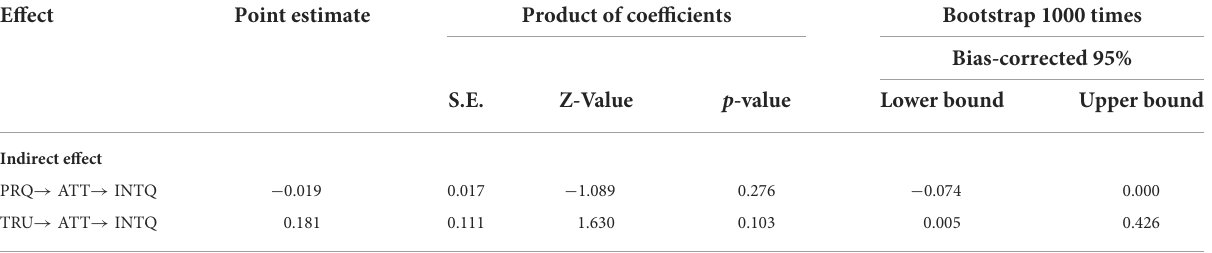
TABLE 7 Analysis of indirect effects of mediation